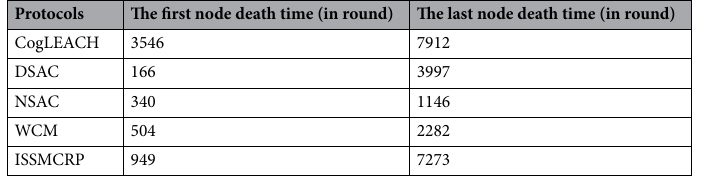
Table 3. Comparison results of network